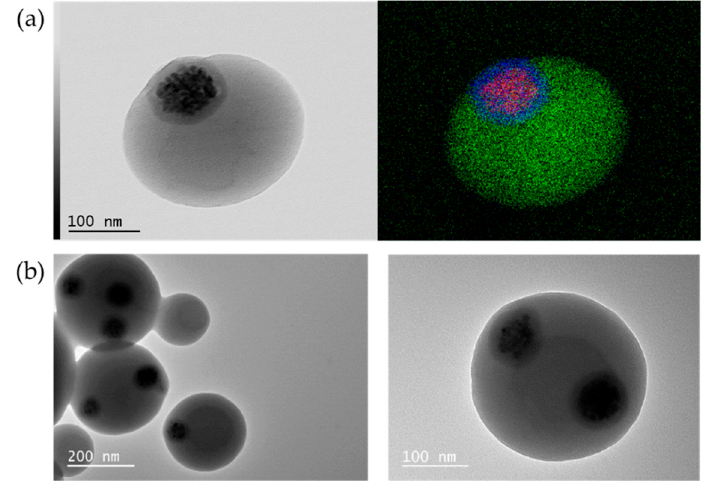
1 Fractions expressed with respect to the magnetic silica seeds, i.e., free PS particles were not considered; 2 multisilica are magnetic silica/PS particles made of two or more seeds; 3 reference experiment carried out from pure silica seeds.